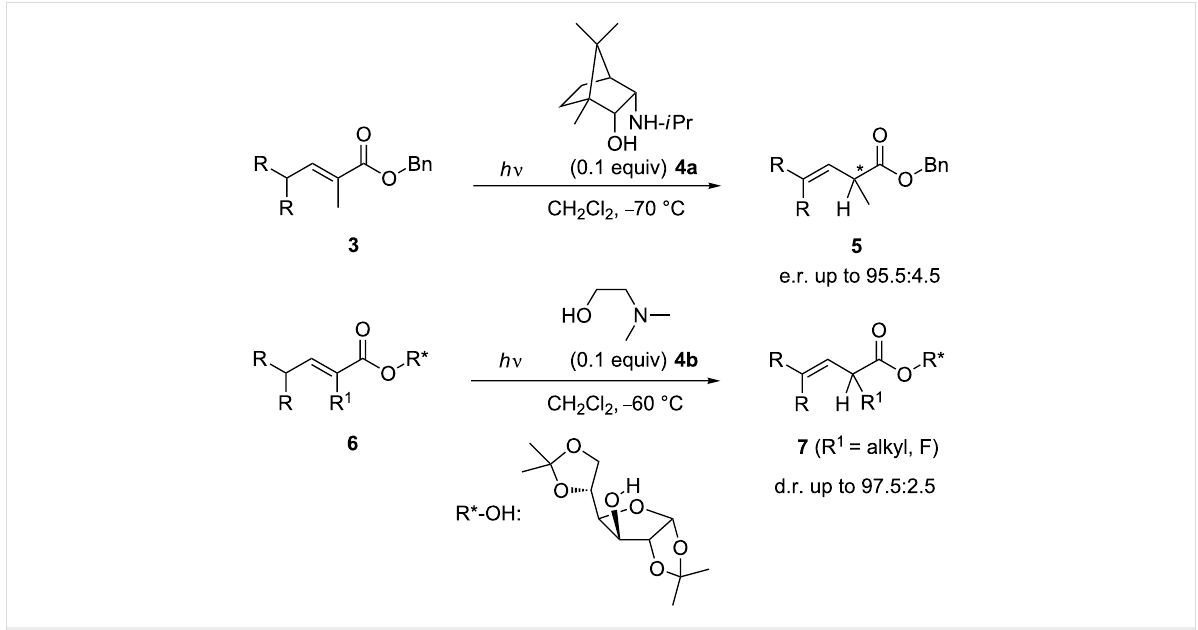
Scheme 2: Enantio- and diastereoselective photodeconjugation reactions.